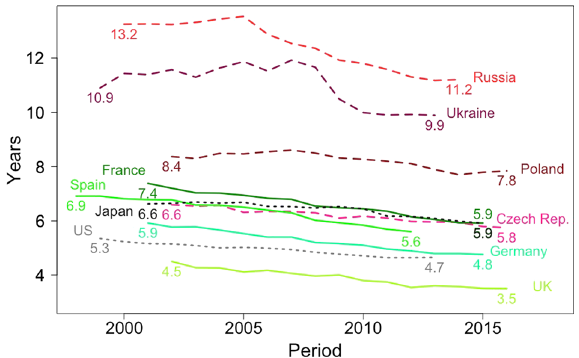
Fig. 2 Sex gap in life expectancy between females and males decreased over the last 15-year period in all the countries